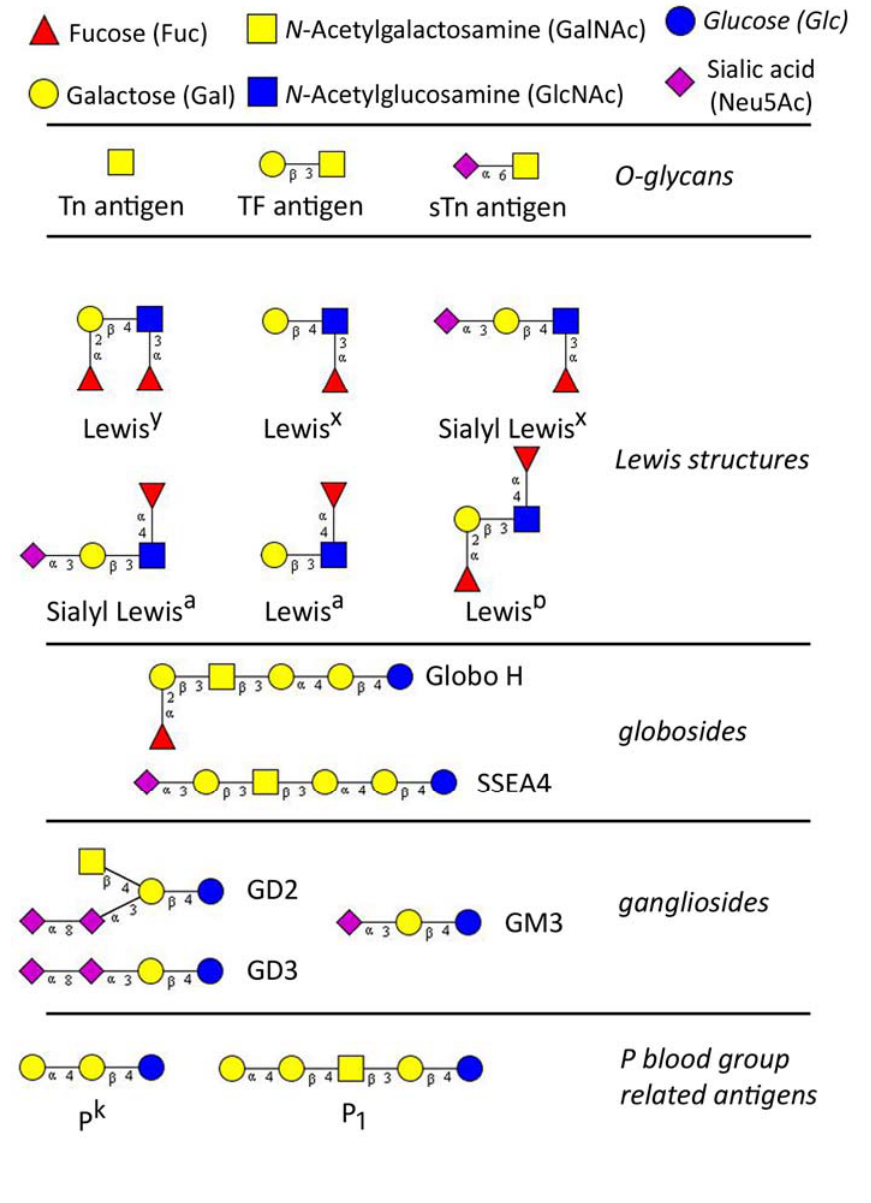
Figure 1. The major tumor-associated glycan determinants, reported to be involved in gynaecological cancers . Glycan structures were designed using GlycoWorkbench